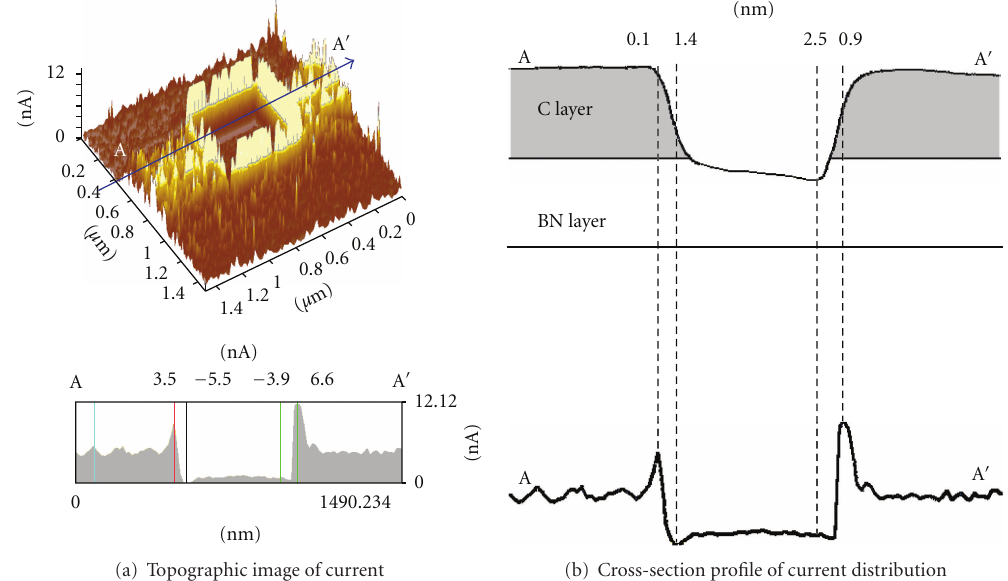
Figure 20: (a) Profile and cross-sectional images of current distribution and (b) model of current versus wear track for 4-nm-period (C/BN)n film at 3500